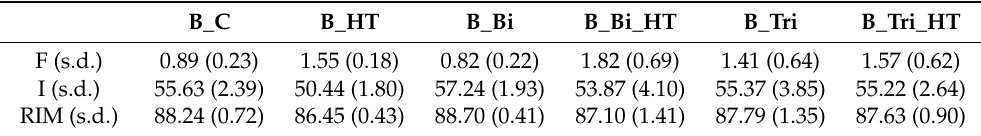
Table 7. HEMI test results for beech (B). Bi = bicine, Tri = tricine, HT = thermal modification, C =